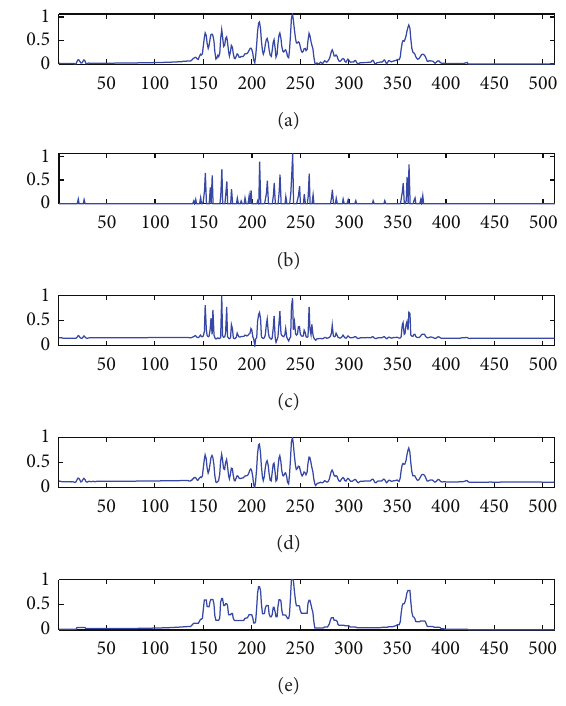
Figure 3: Measured signals results. (a) Envelope of measured signal; (b) results obtained with our algorithm; (c) results obtained with 𝑙 1 - norm; (d) results obtained with Wiener filter; (e) results obtained with TV-norm. Table 4: Resolution gain evaluation on measured signals. Criteria Our